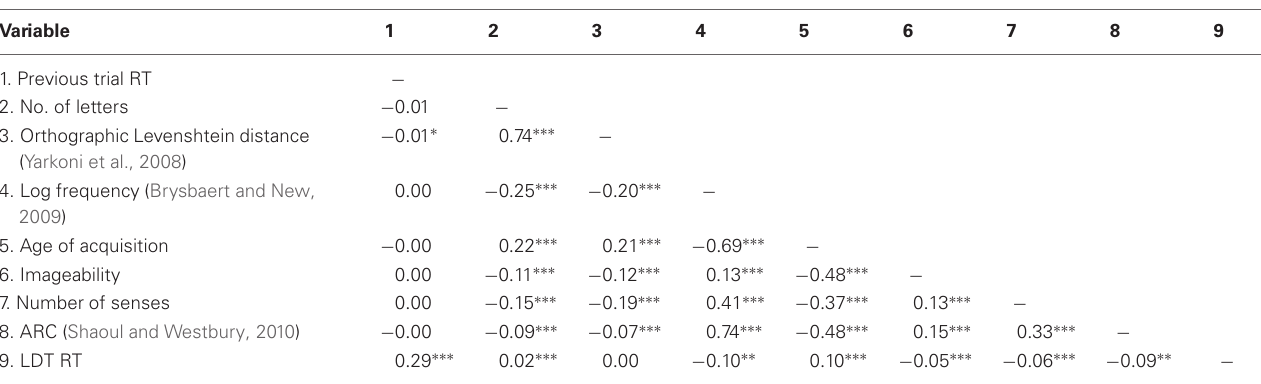
Table 3 | Correlations between centered predictor variables and dependent variable for 3723 words.